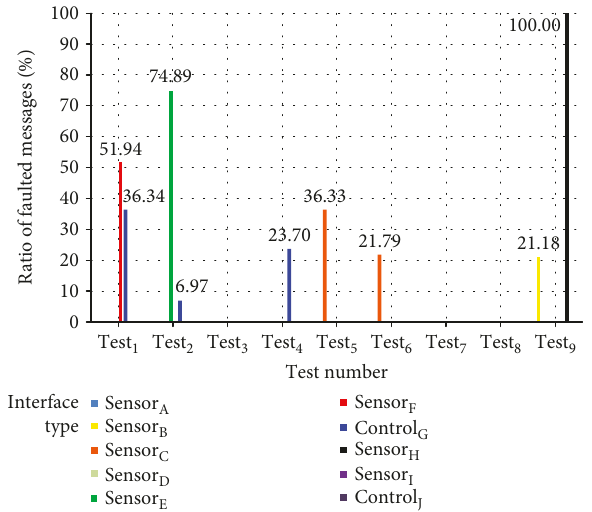
Figure 10: Fault ratio at interface